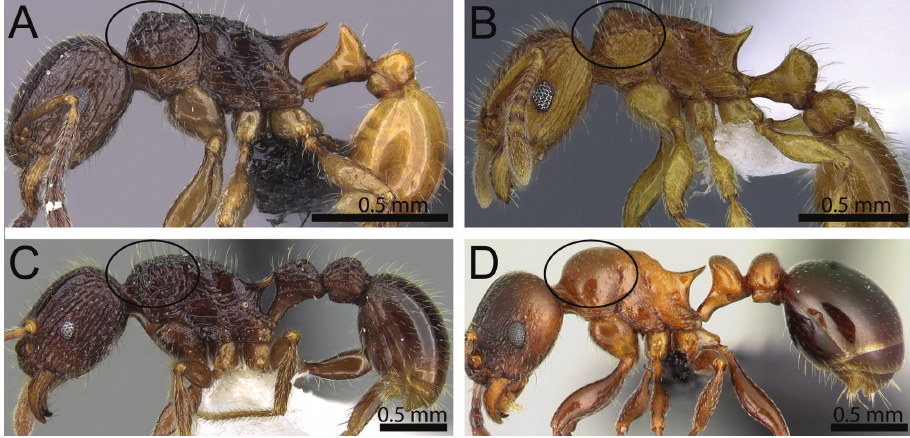
Figure 8. Body in profile (anterodorsal pronotum within black circles). A T. bonibony (CASENT0486252) B T. trafo (CASENT0404104) C T. singletonae (CASENT0247161) D T. wardi (CASENT0475483). 9 First gastral tergite with strongly appressed pubescence of varying length and